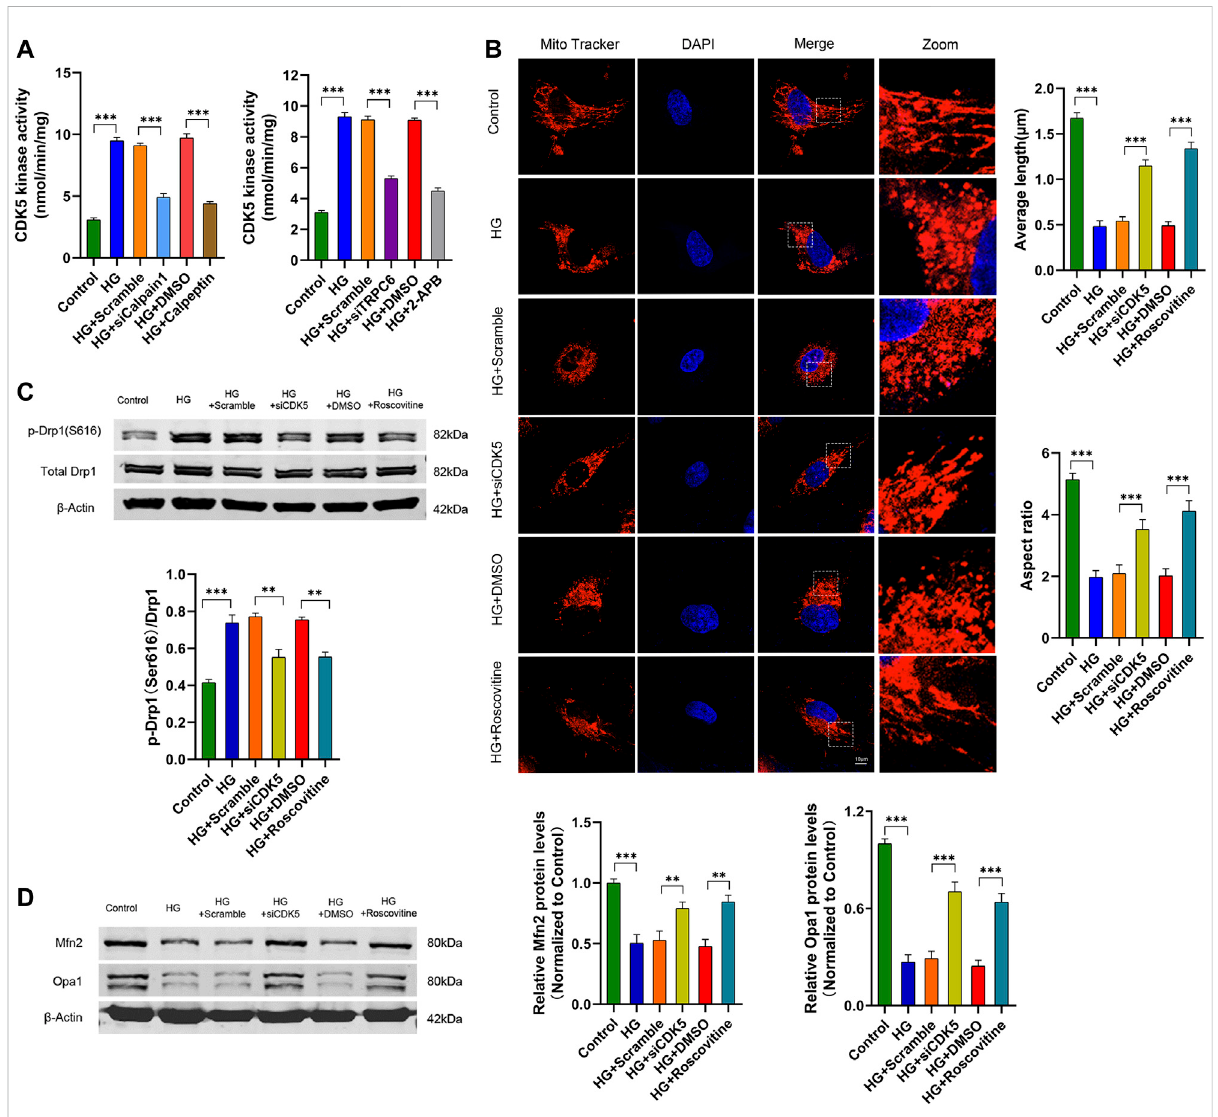
HG, HG + scramble, HG + siTRPC6, HG + DMSO and HG + 2-APB groups (right) ( n = 5 independent experiments). (B) MitoTracker Red and DAPI staining,and analysis ofaverage length and aspectratioby ImageJ software inthecontrol,HG, HG + scramble, HG +siCDK5, HG + DMSO,